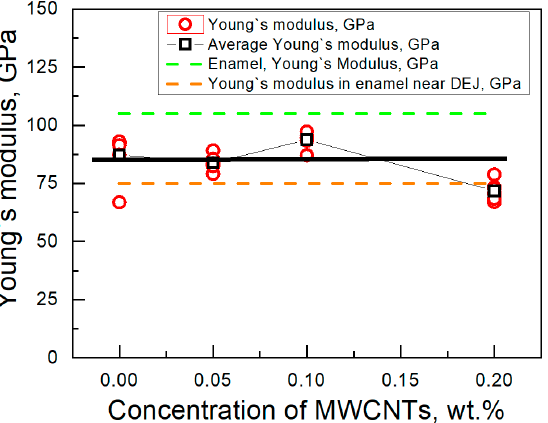
Figure 6. Young’s modulus vs. concentration of MWCNTs. Indentation test (red circles), Average value of the composite HA/MWCNTs (open square). Line shows for the eye the literature values of Young’s modulus for enamel (green line) [61], and Dentin-Enamel Junction (orange line)